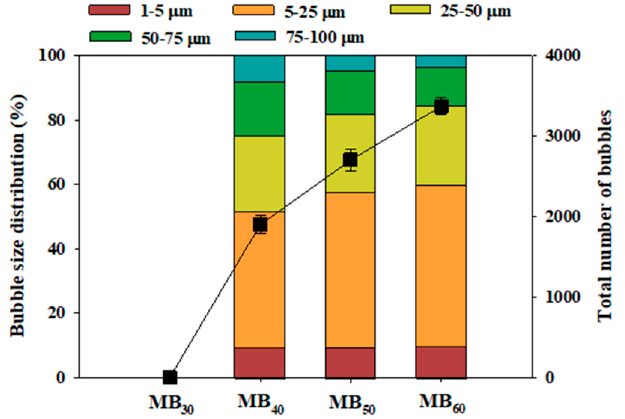
Figure 3. The size distributions and the total number of the microbubbles generated by the cavity pump at the different frequencies (temperature = 20 °C).